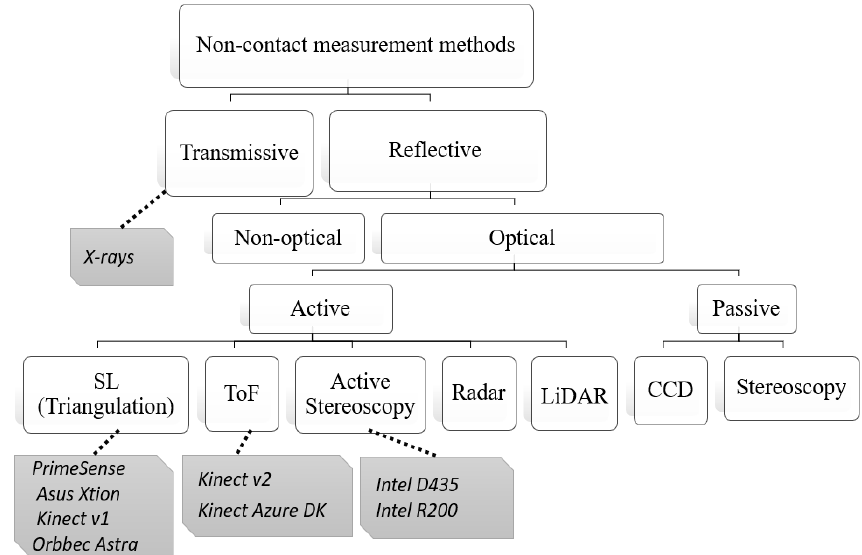
Figure 2. Non-contact sensors’ technology classification: SL = Structured-Light, ToF = Time-of-Flight, LiDAR = Light Detection and Ranging, CCD = charge coupled device.